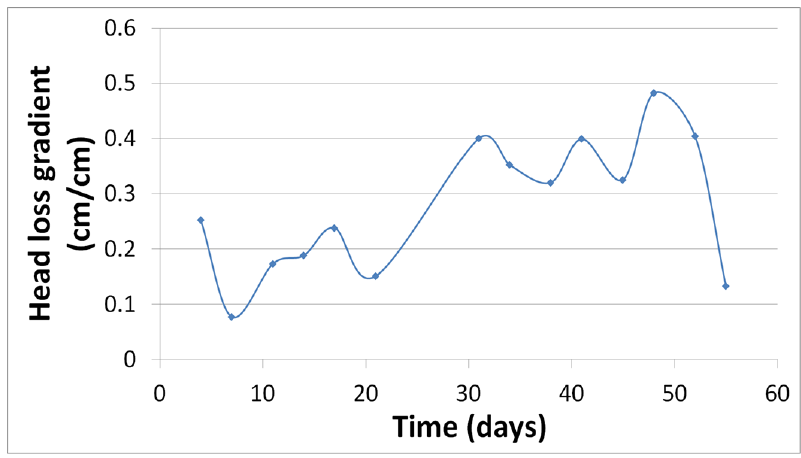
Figure 3. Head loss gradient as a function of time in Phase I.